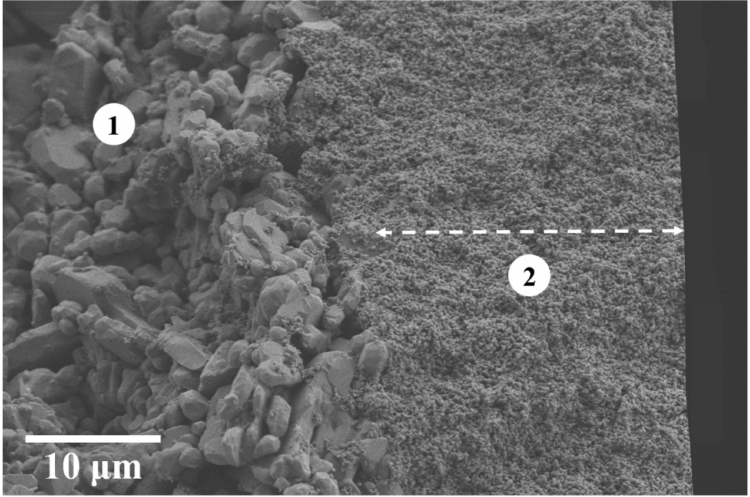
Figure 4. Cross-sectional SEM image of the asymmetric multichannel cylindrical tube-type substrate; (1) alumina macroporous support; (2) double-coated alumina microfiltration